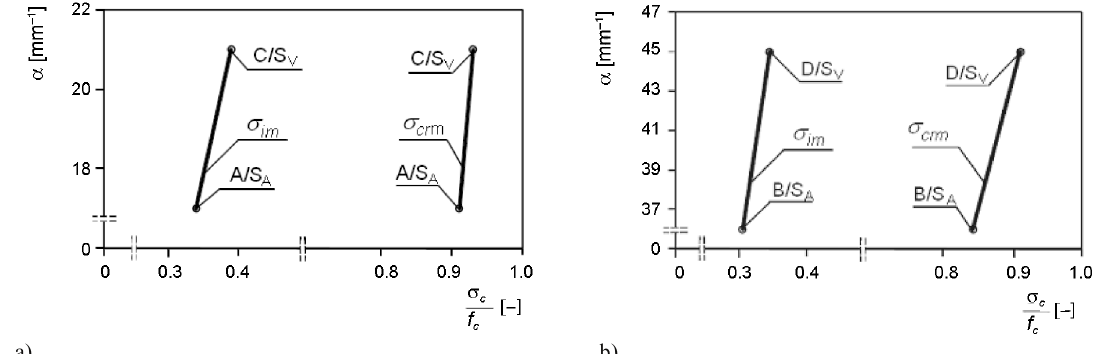
Fig. 15. Dependence of average relative levels of stress σ im and σ crm on specific air pore surface area α in hardened self-compacting concrete (pore diameter range 10–4000 μ m): a) A/S A and C/S V ; b) B/S A and D/S